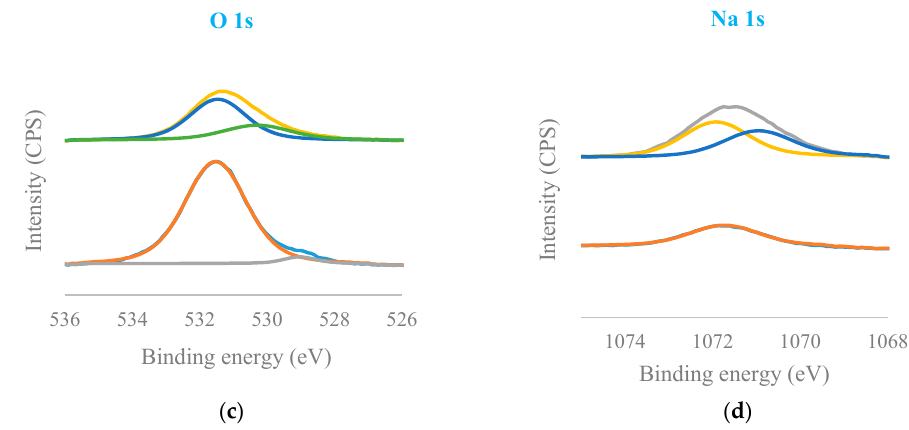
Figure 3. Deconvoluted XPS spectra of C 1s ( a ); Ca 2p ( b ); O 1s ( c ); and Na 1s ( d ) of Na-COS (top) and COS (bottom).